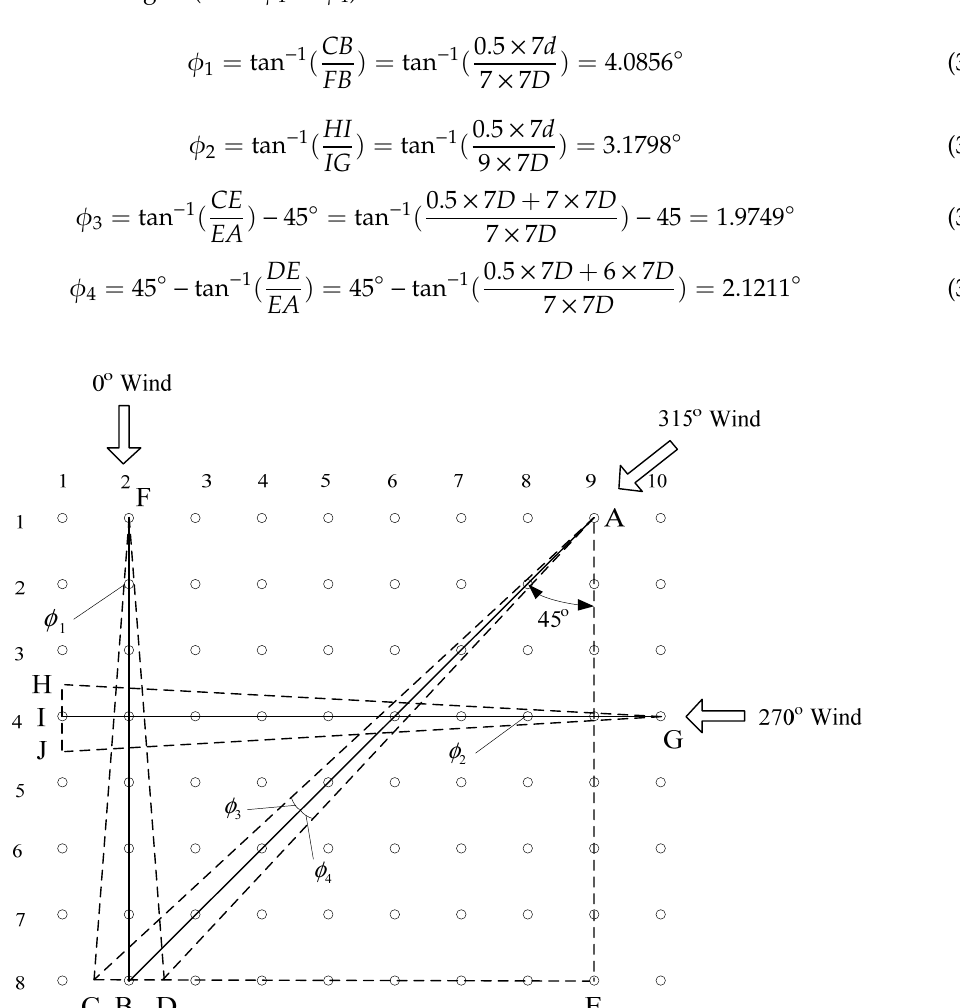
Figure 7. Angle tolerance in the case of a wind angle of 315° in the Horns Rev OWF,